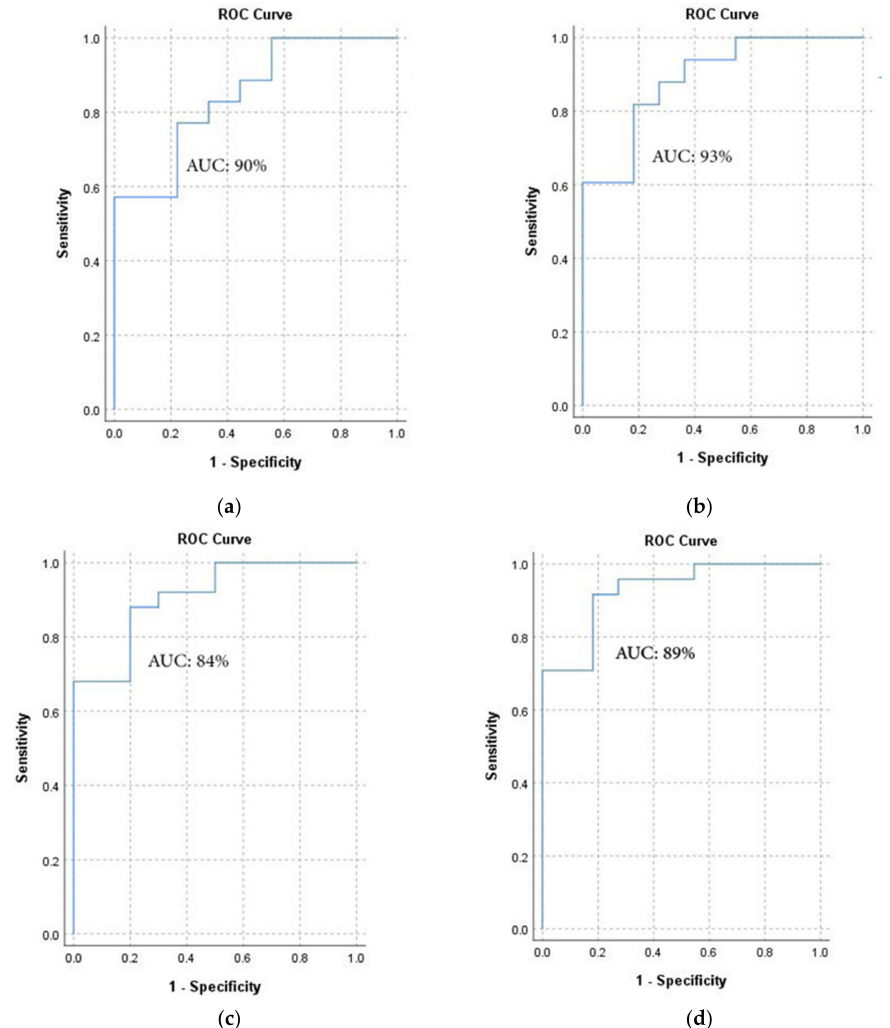
Figure 6. Success Rate (SR) and Prediction Rate (PR) curves for the FAHP and FBWM models. ( a ). SR- area under the curve (SR-AUC) for the FAHP; ( b ). SR-AUC for FBWM; ( c ). PR-AUC for the FAHP; and, ( d ). PR-AUC for